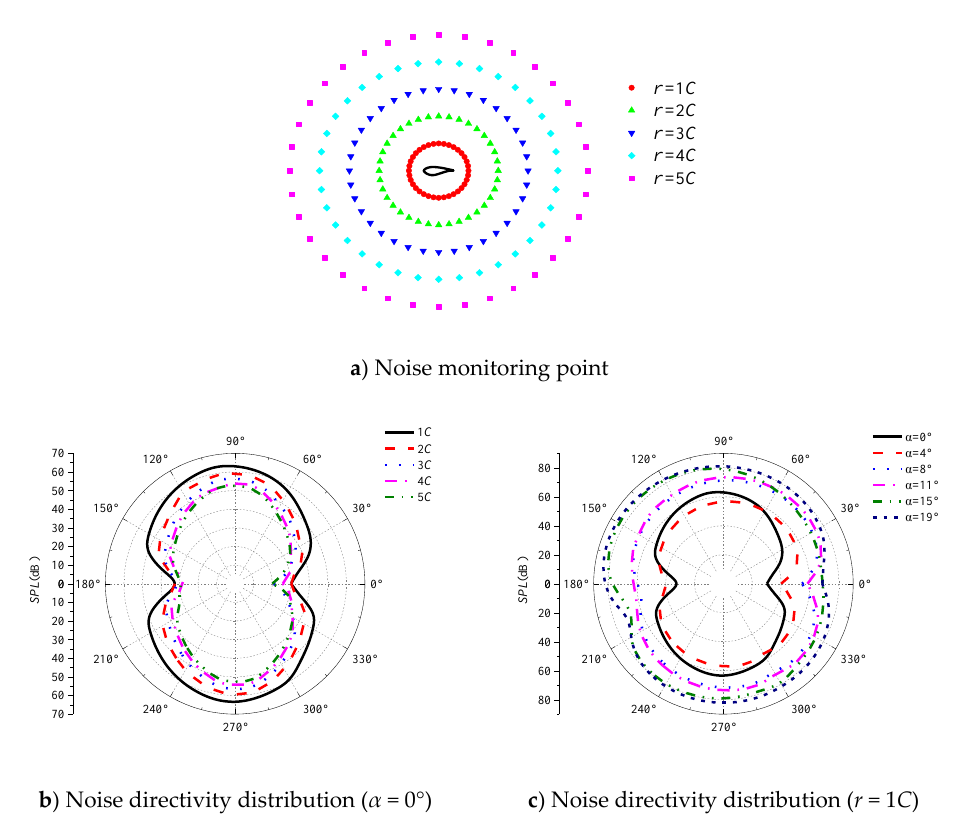
Electronics 2019 , 8 , x FOR PEER REVIEW Figure 11. C p distribution of the airfoil with and without the NLPS. Figure 11. C p distribution of the airfoil with and without the NLPS.